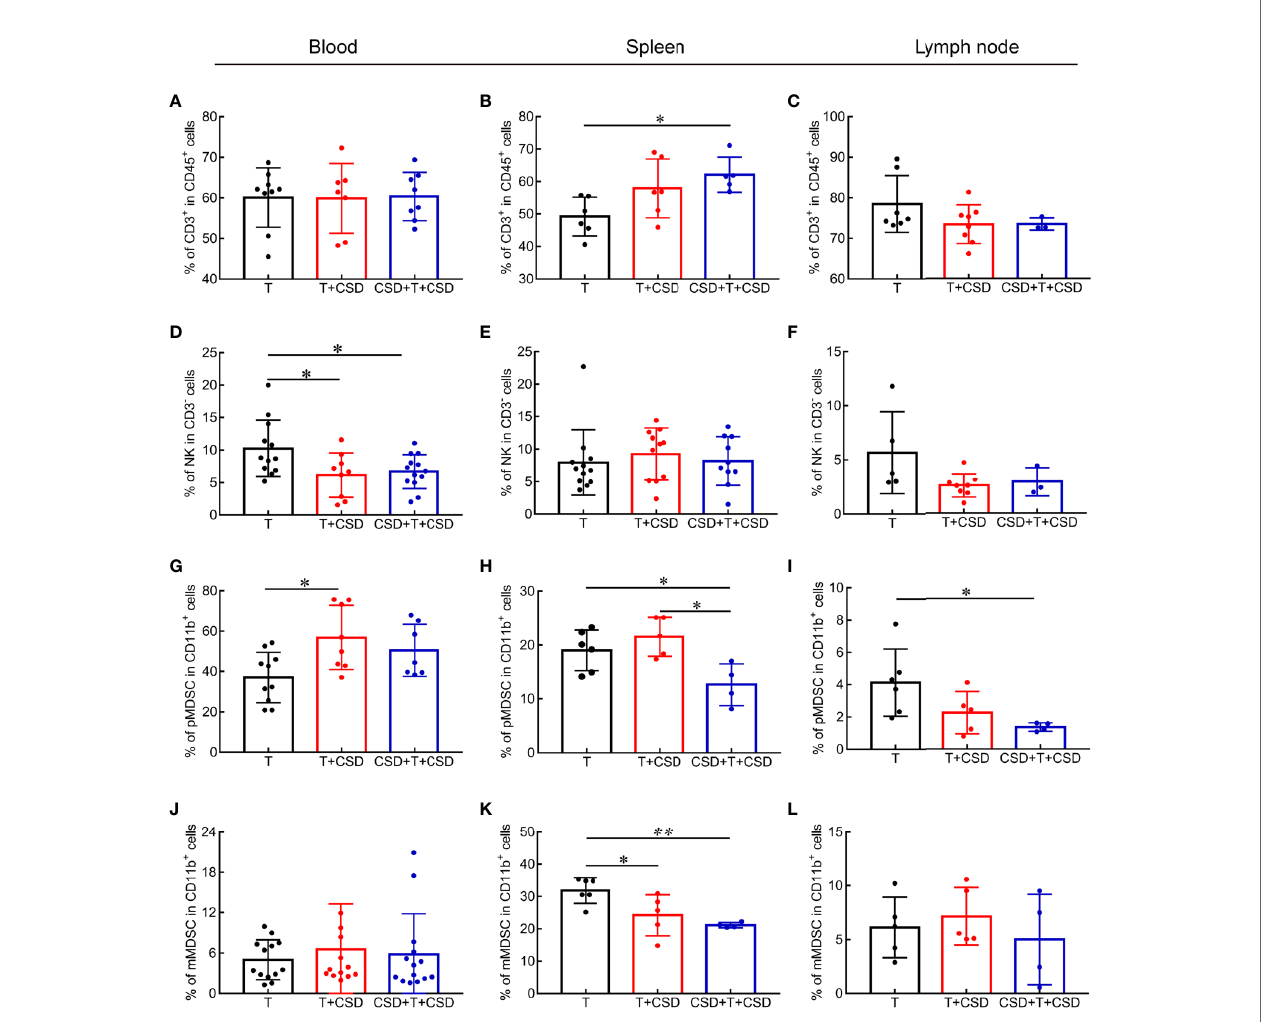
FIGURE 5 | CSD redistributes immune cells in the circulation and peripheral immune organs (spleen and lymph node) in tumor-bearing mice. (A – L) CSD-induced changes in the percentages of CD3 + T cells (A – C) , NK cells (D – F) , PMN-MDSCs (G – I) , and MN-MDSCs (J – L) in blood (A, D, G, J) , spleen (B, E, H, K) , and lymph node (C, F, I, L) in tumor-bearing mice after CSD. Data are presented as mean ± SEM. * p < 0.05, ** p <